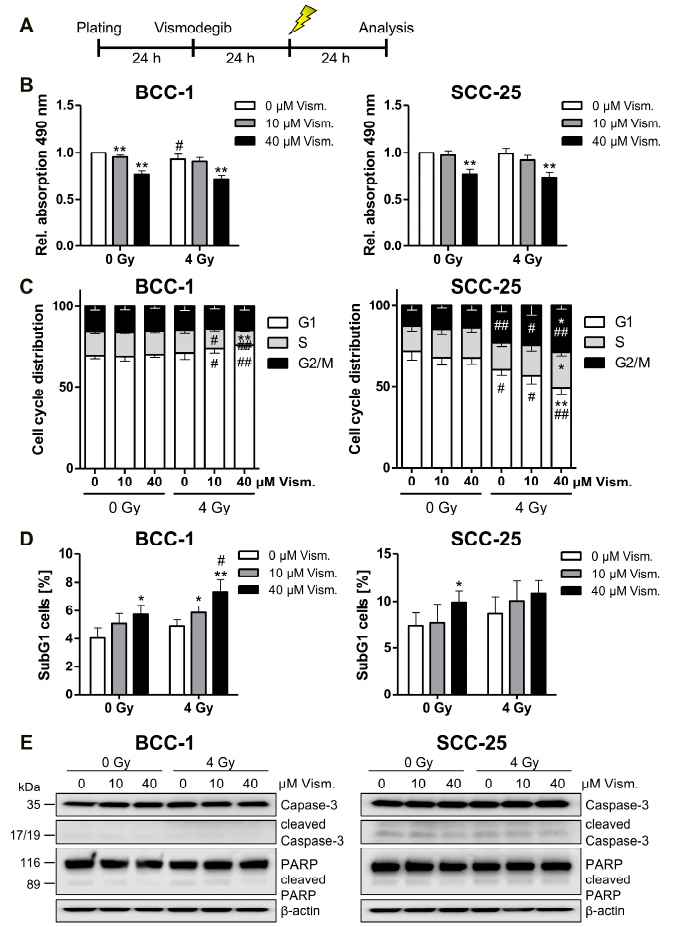
Figure 3. Vismodegib and irradiation modulate cell viability, cell cycle distribution and SubG1 cell fraction content. BCC-1 and SCC-25 cells were pretreated for 24 h with indicated concentrations of vismodegib or DMSO as control before a 4 Gy irradiation ( A ). At 24 h after irradiation, proliferation/viability was measured with a CellTiter 96 ® Aqueous One Solution Cell Proliferation (MTS) Assay ( B ). Cell cycle distribution ( C ) and SubG1 cell fraction ( D ) were analyzed after propidium iodide staining by flow cytometric quantification. Caspase 3 and PARP expression/cleavage was detected by Western blotting ( n = 2) with β -actin as loading control ( E ). Data given in ( B – D ) are shown as means + SD from four independent experiments with quadruplicates (MTS assay, ( A )) or duplicates (flow cytometry ( B , C )). Differences were considered as statistically significant when * p < 0.05 or highly significant when ** p < 0.01; vismodegib- versus DMSO-treated cells ( t -test). Significant differences between irradiated and non-irradiated cells are indicated as follows: # p < 0.05, ## p < 0.01 ( t -test). Gy, Gray; PARP, poly ((adenosine diphosphate)ADP-ribose) polymerase; Rel., relative; Vism.,